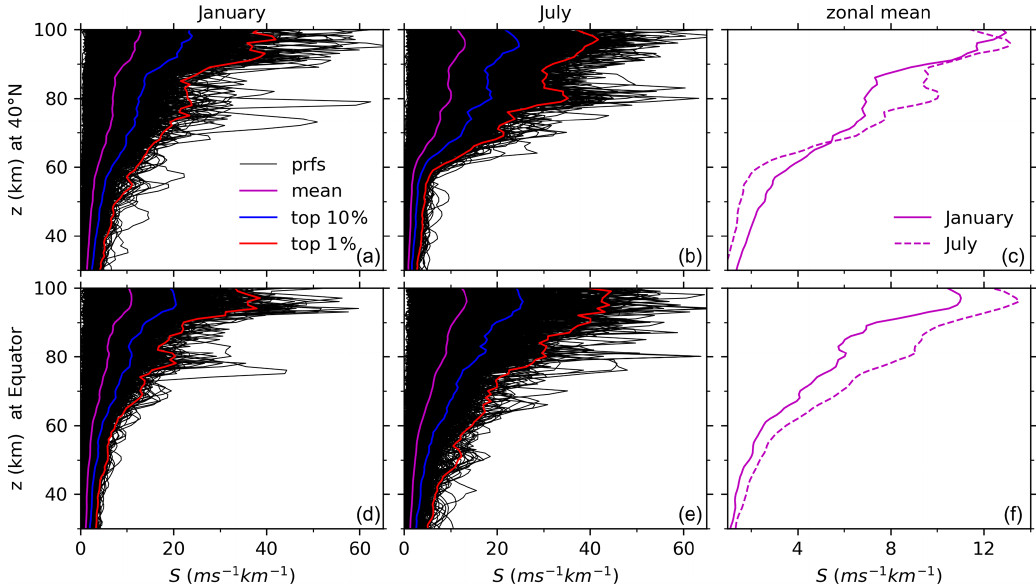
Figure 5. Profiles (prfs) of S (black) and their mean (magenta) as well as the top 10% (blue) and 1% (red) largest S during January (a, d) and July (b, e) at around 40 ◦ N (a, b, c) and the Equator (d, e, f) . The zonal means of S during January (solid) and July (dashed line) at the two latitudes are also shown in (c) and (f) for comparison. Same x -axis ( y -axis) scale is used in each row